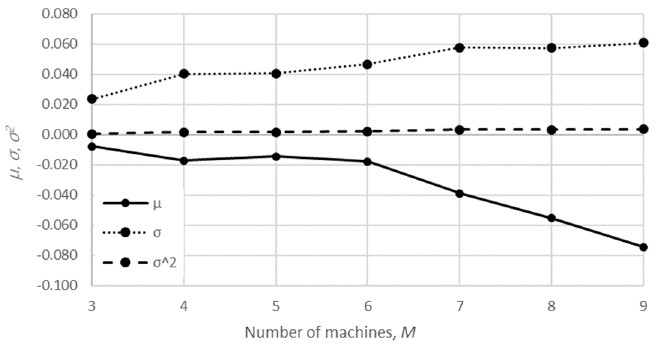
Figure 10. The relative error of the PR concerning the number of machines—FSM.